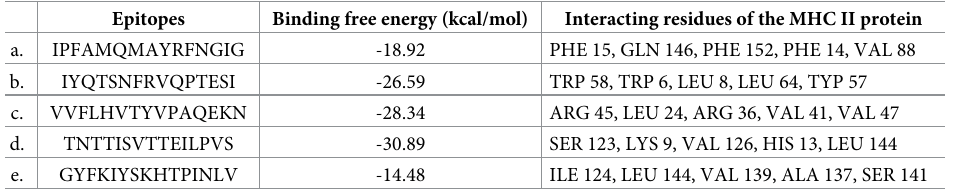
Table 7. Docking properties of HLA-DRB1 � 01:01 restricted epitopes. Epitopes Binding free energy